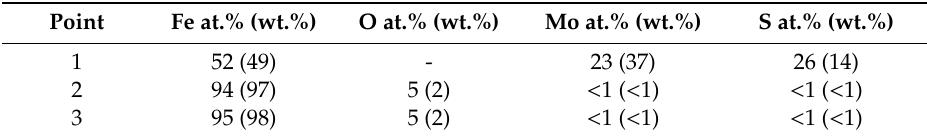
Table 6. EDS point analysis of a sintered Fe sample (for pressing pressure 350 MPa) containing 2.5% MoS 2 with a grain size of 1.5 µ m.